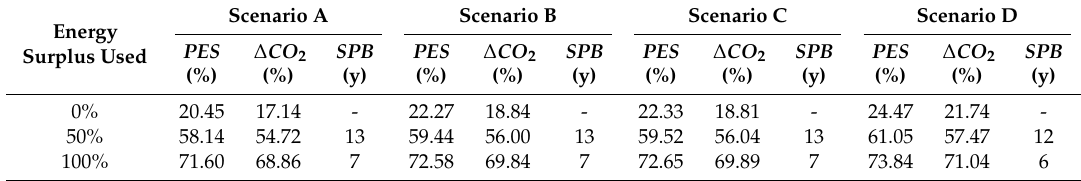
Table 8. Best energy, environmental and economic results with evacuated tube